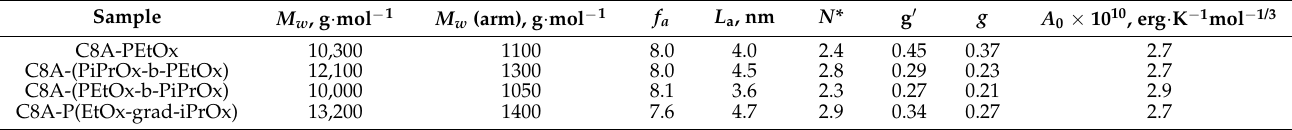
Table 2. Structure characteristics and contraction factors for star-shaped CA8-PAlOx.